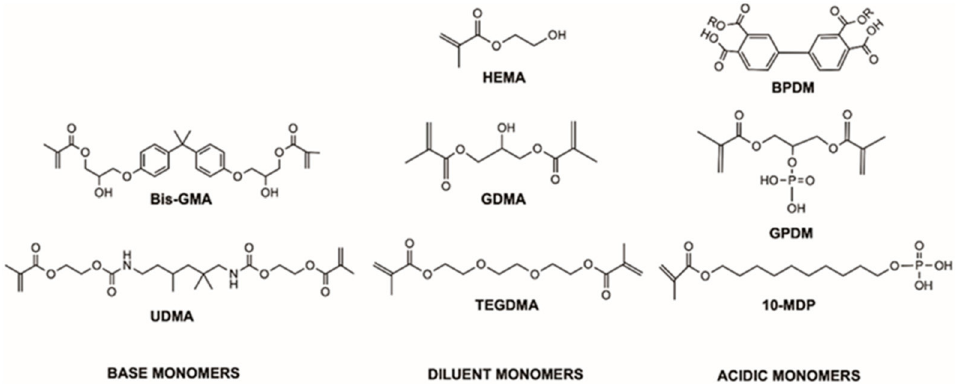
Figure 1. Chemical structure of monomers used in the commercial adhesives tested in this study, drawn with ChemBioDraw Professional (Perkin-Elmer, MA, USA) (BPDM is formed through reaction of anhydride groups on its benzene rings with the OH group on HEMA making R = C 2 H 4 MA, where MA is a methacrylate